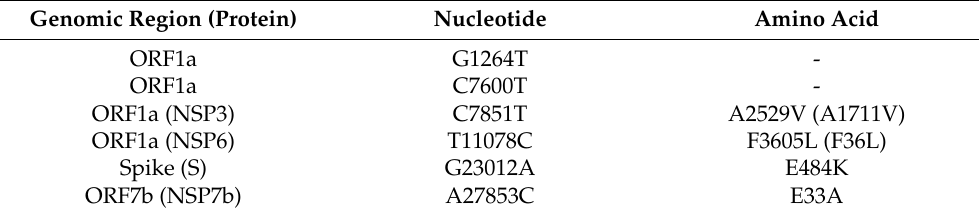
Table 1. Synapomorphic mutations of SARS-CoV-2 lineage N.9. Genomic Region